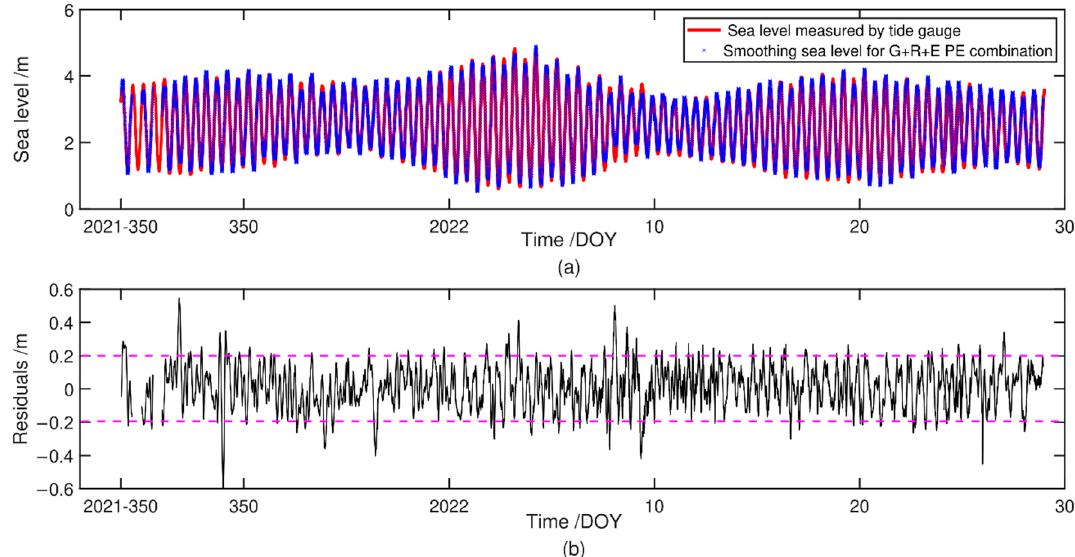
Figure 15. Sea surface heights derived from multi-GNSS PE combination arcs and its residuals with tide gauge. ( a ) Sea surface height estimation; ( b ) residuals between the estimations and in situ meas- urements.